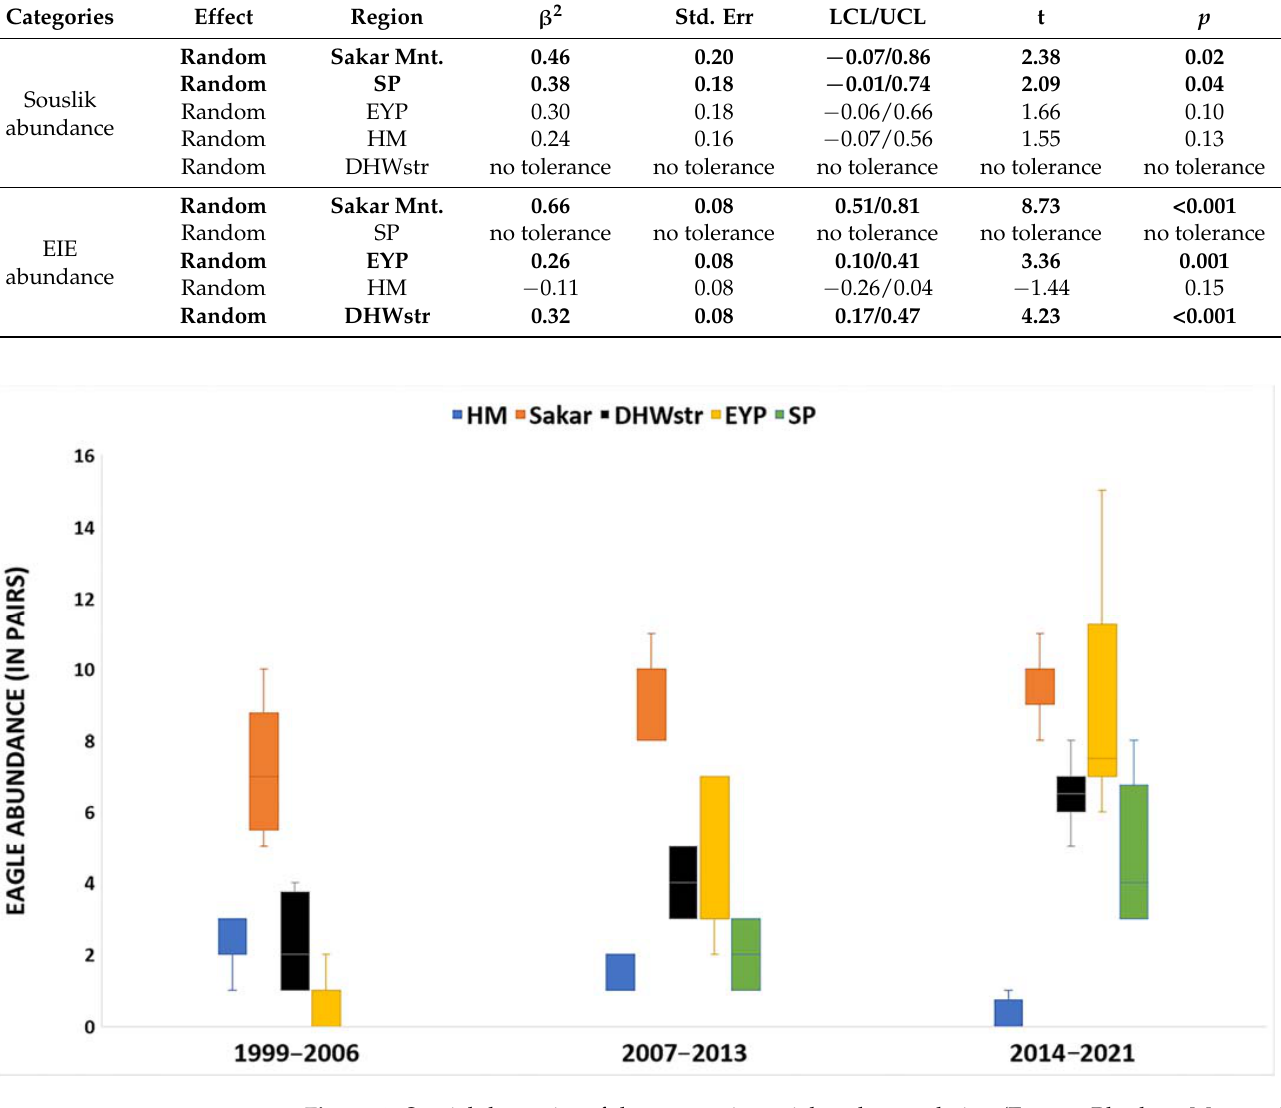
Table 3. Results of the general linear mixed model (GLMM) carried out to analyze the trend of souslik abundance and eastern imperial eagle (EIE) abundance in different regions. We used explanatory parameter estimates ( β 2 ) ± standard error, with lower (95%) and upper CL (95%) and a probability value ( p ) of the tested categories. Significant values are given in bold.